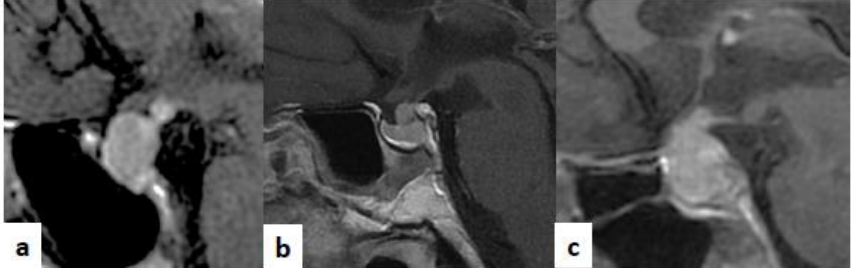
Figure 3. Sagittal T1-weighted (T1-w) images after contrast medium injection. ( a ) A case of adeno-